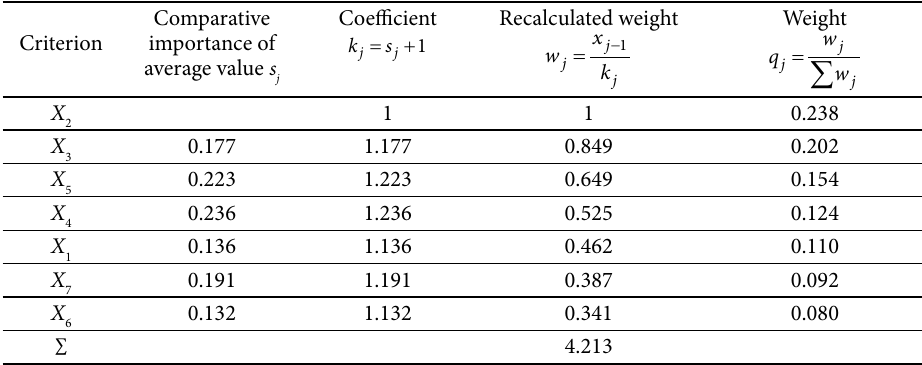
Table 3. Final results of SWARA method in weighting